Question: Name the type of graph shown.
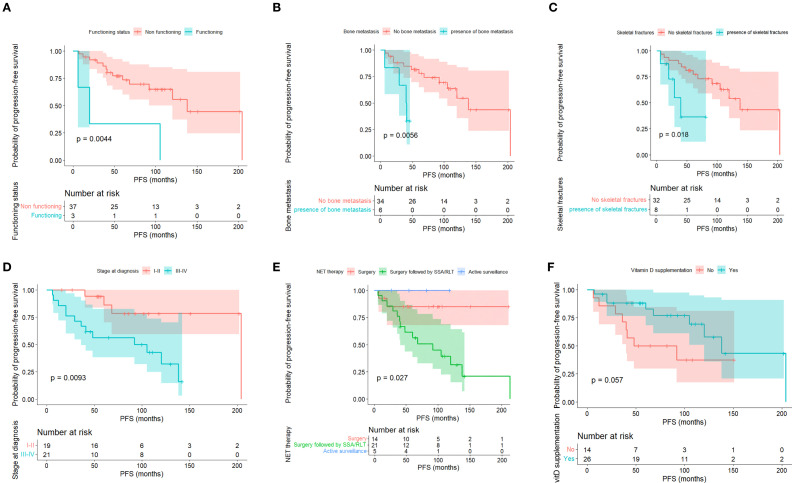
Answer: survival